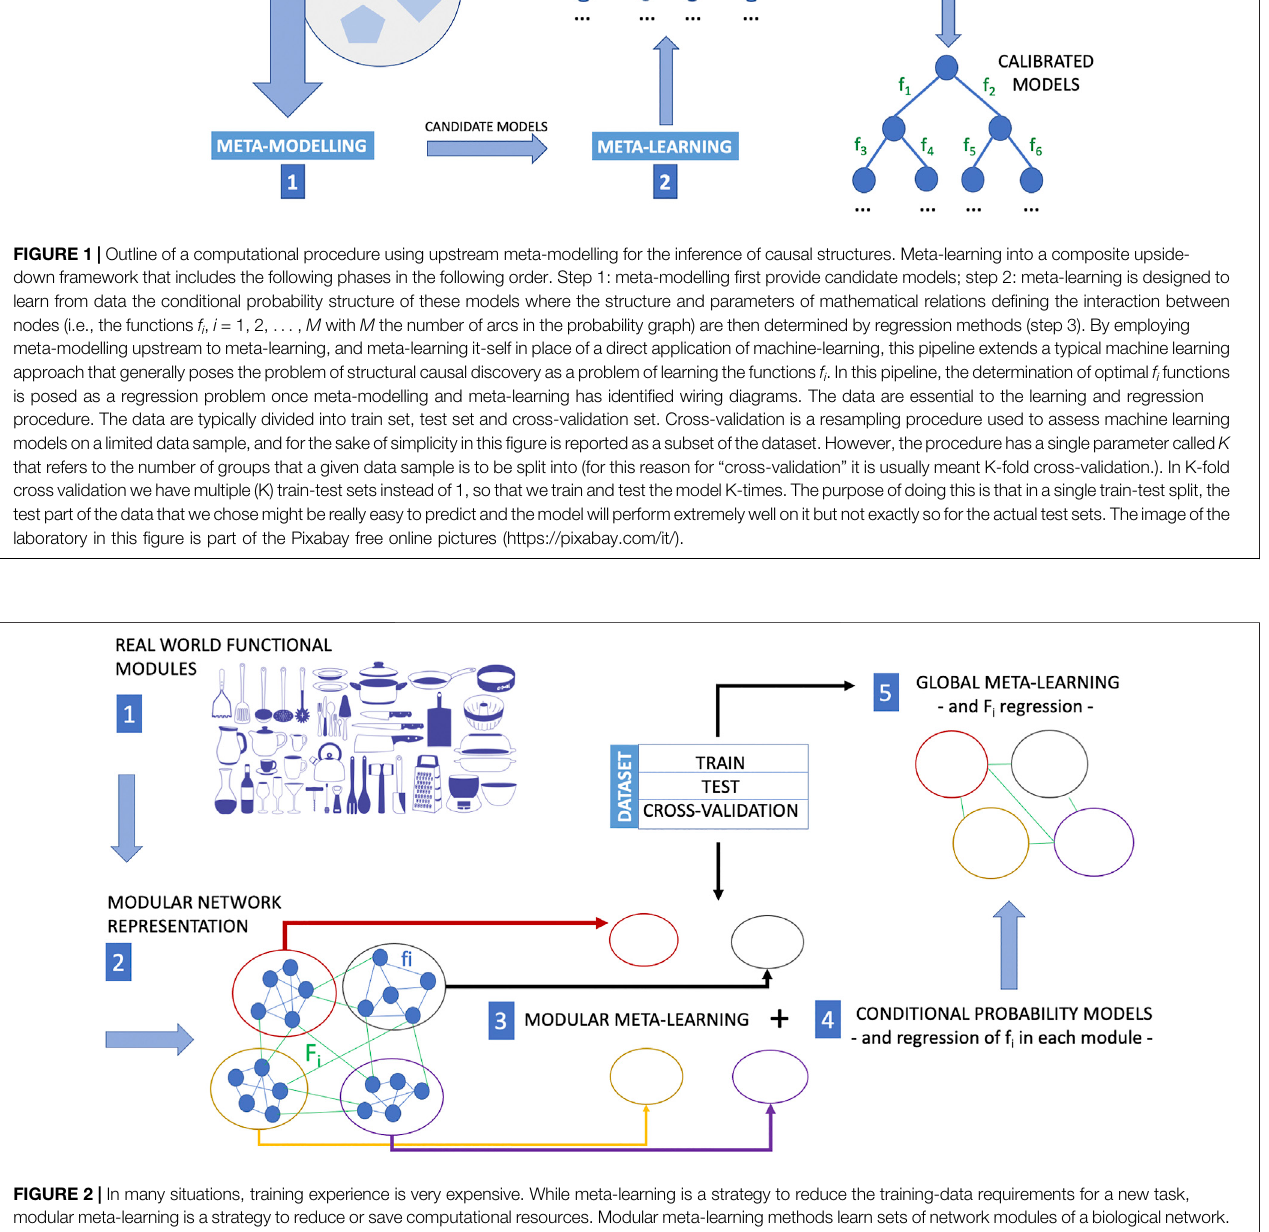
Frontiers in Bioinformatics |